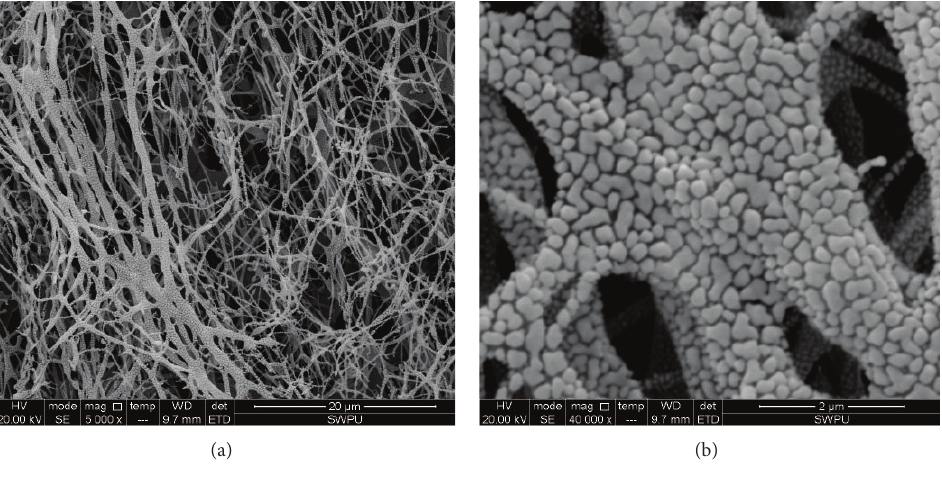
Figure 5: SEM images of AM/AA/NSFM. Table 2: The relevant core properties and the results of core flooding experiments.